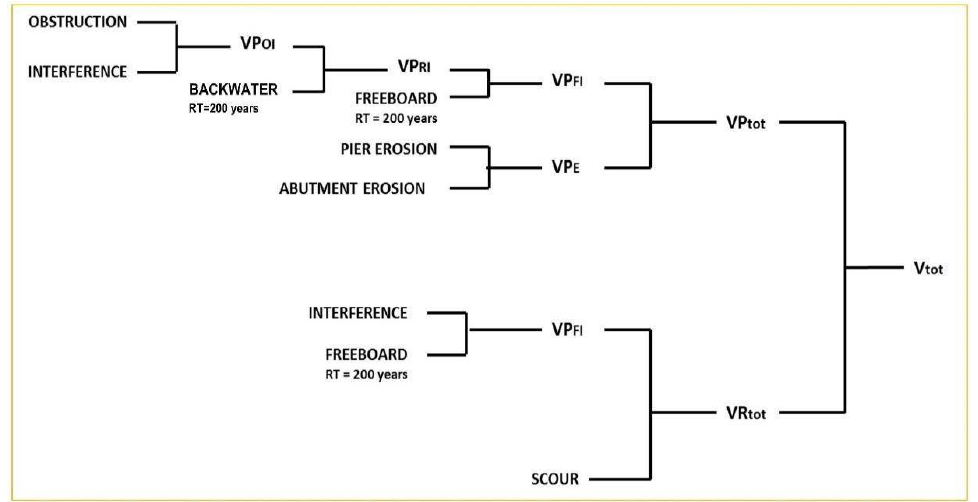
Figure 3. Flow chart describing the methodology employed to evaluate the vulnerability of a bridge structure.